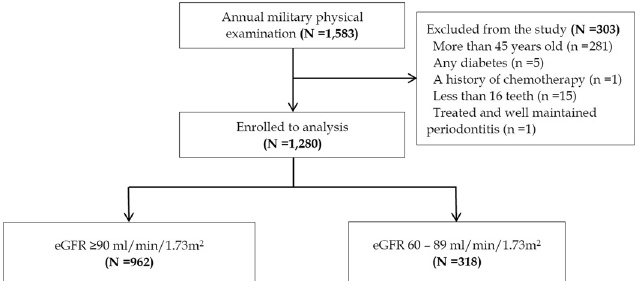
Figure 1. Flow diagram for selection of participants and design of the CHIEF oral health